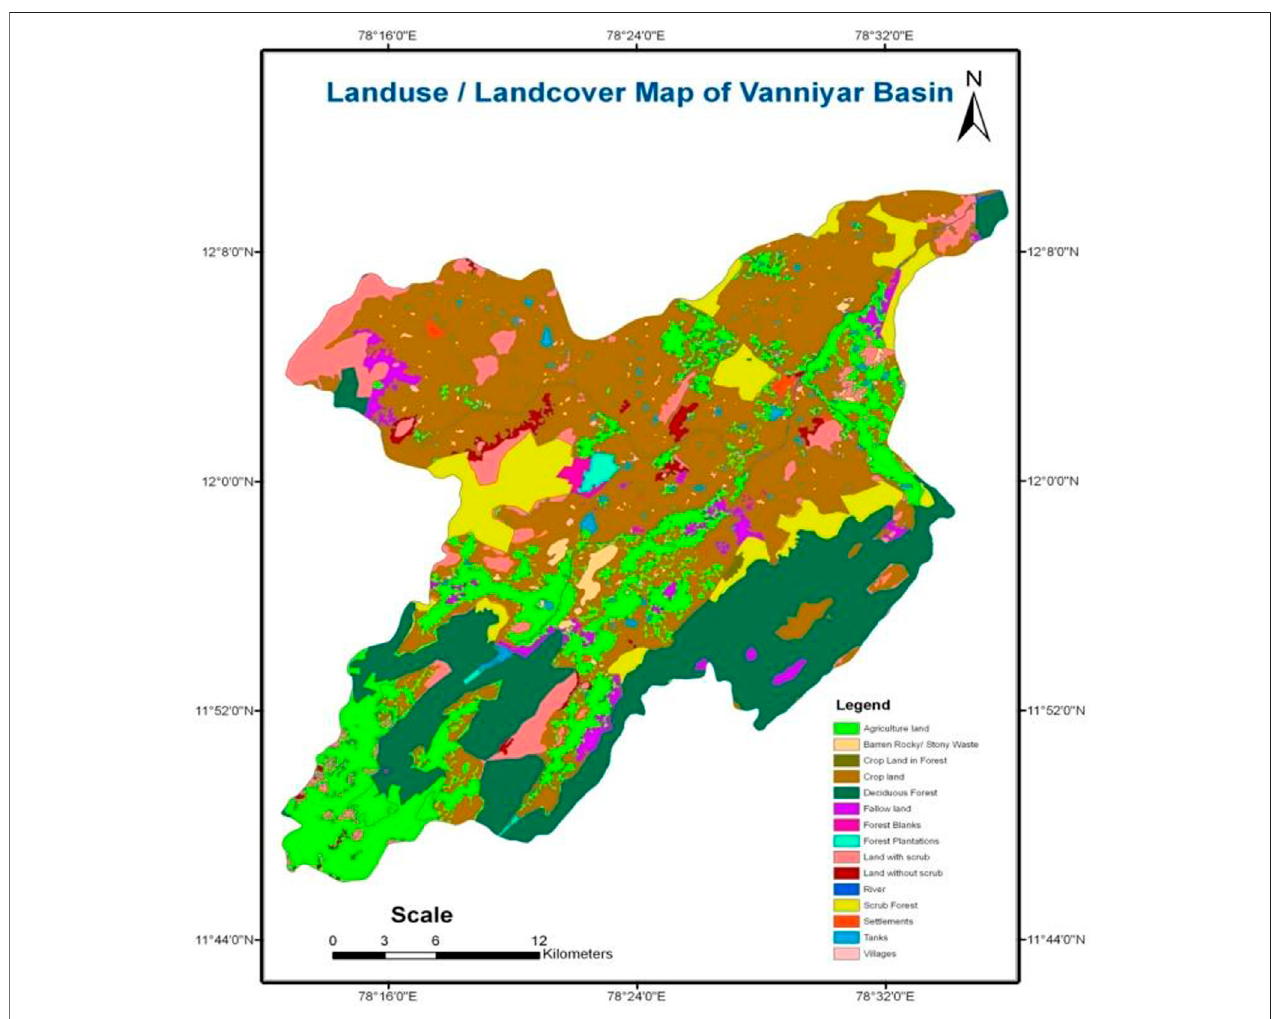
FIGURE 8 | Land use and land cover map of the Vanniyar basin, Dharmapuri district, Tamil Nadu, India.